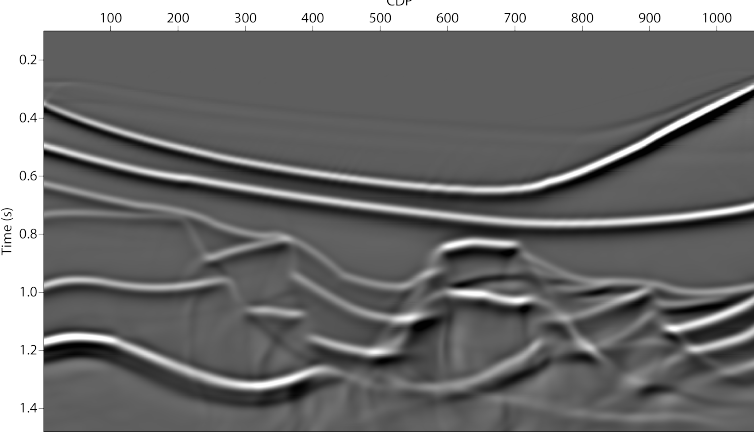
Figure 2. Synthetic marine velocity model. The velocity model consists of a water layer and several sedimentary layers, with values varying from 1500 to 4000 m/s. The viscous acoustic seismic record was modeled to test the effectiveness of the QPSTM with a same size Q model (not shown here).